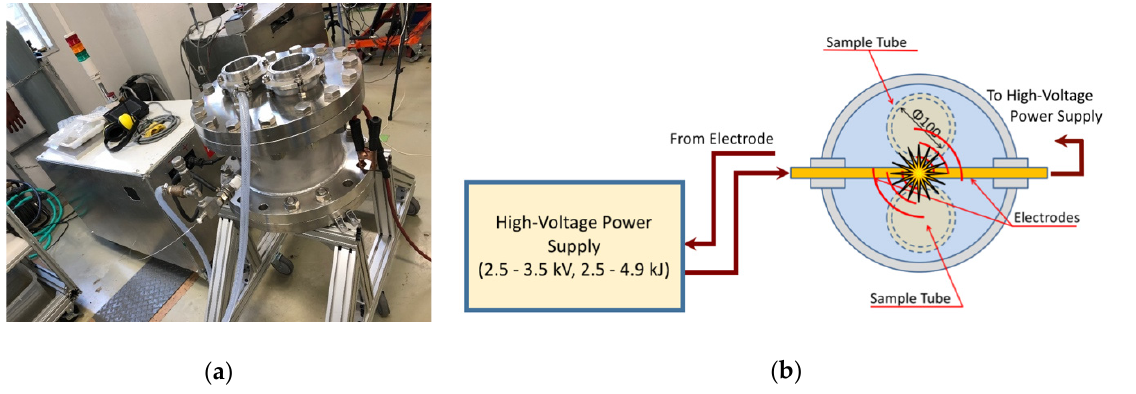
Figure 1. Schematic of the experimental setup: ( a ) overview of high-voltage power supply and vessel and ( b ) top view of the vessel.